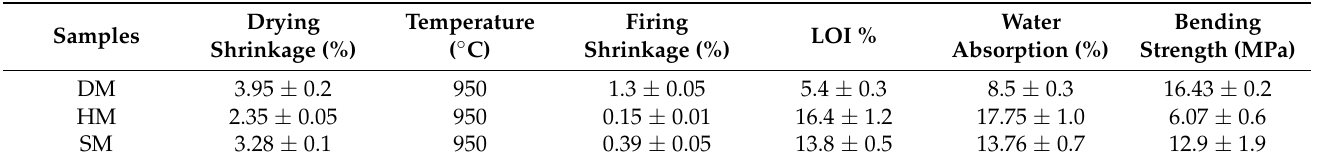
Table 6. Technological features of fired hollow brick samples at 950 ◦ C.